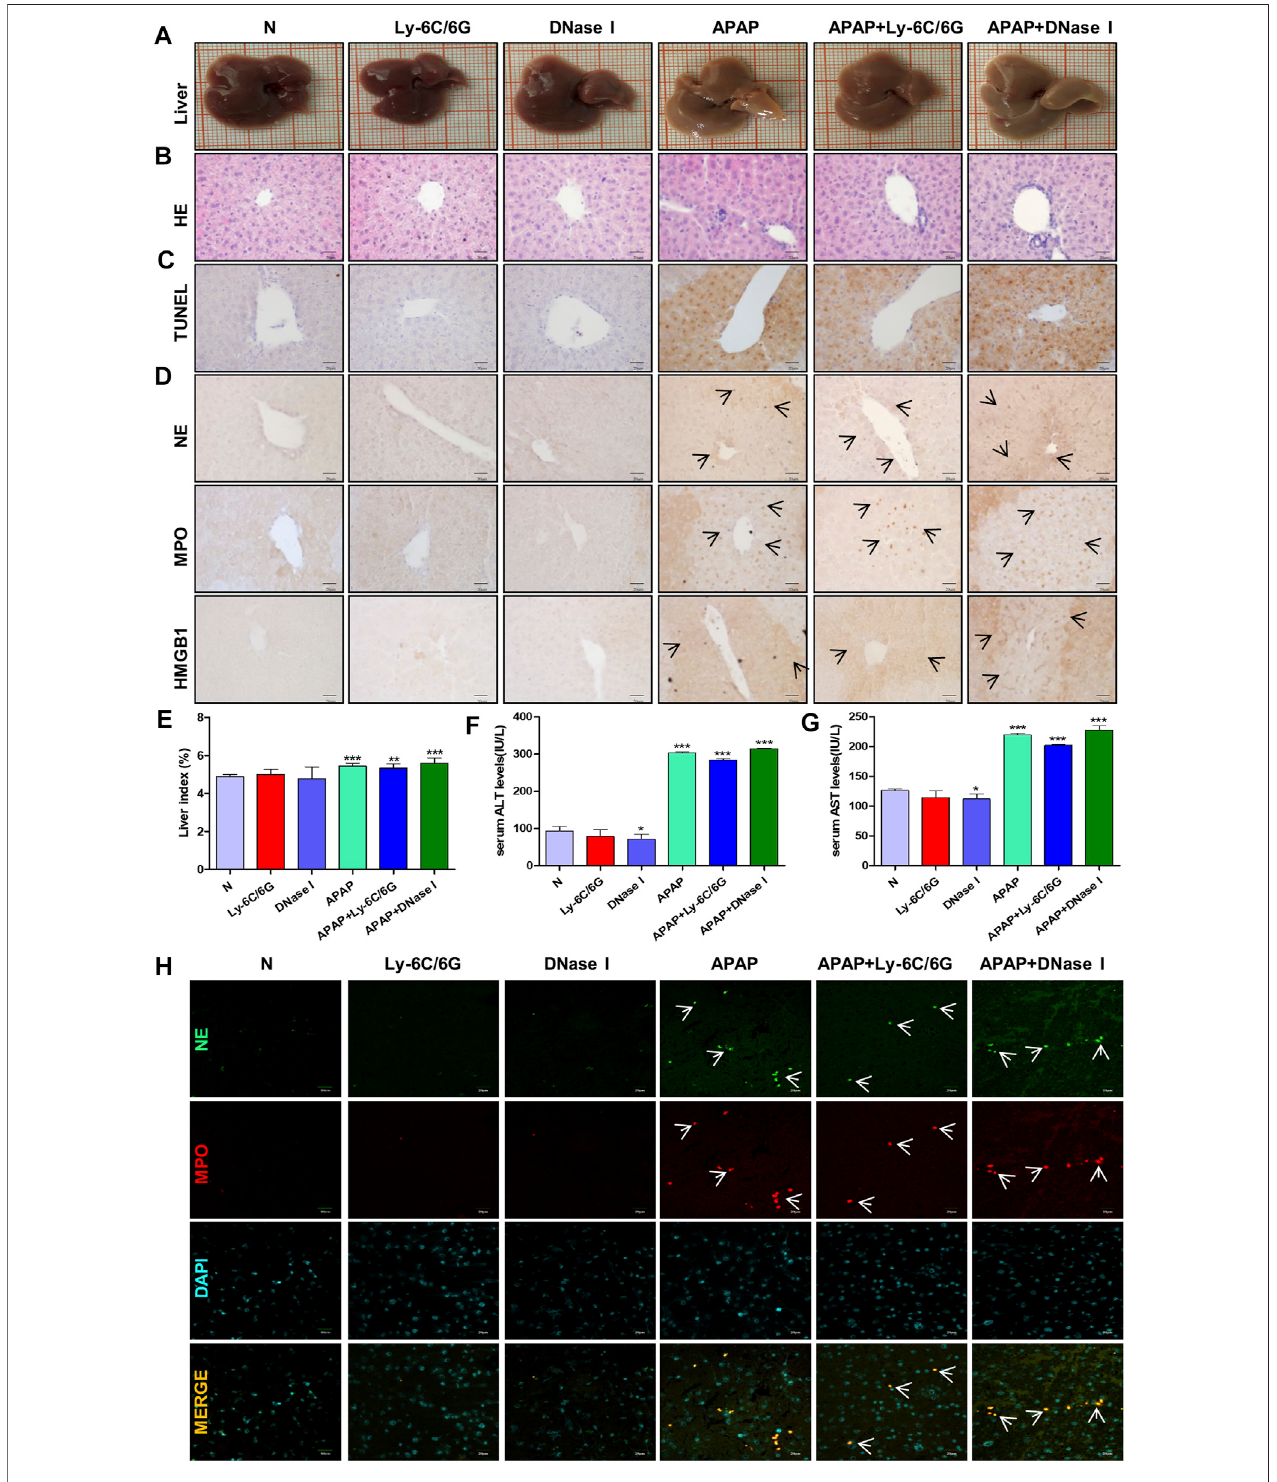
FIGURE7| Effects ofneutrophilsand NETs onliver injuryinduced byAPAP. C57BL/6 mice wererandomlydivided intosixgroups: normal group,Ly6C/6G group, DNase I group, APAP group, APAP + Ly6C/6G group and APAP + DNase I group. Ly6C/6G (200 μ g/mouse) was injected intraperitoneally 24 h before APAP (300 mg/kg) treatment. DNaseI(10 mg/kg) wasinjectedintraperitoneally1 hafter APAPtreatment. (A) Morphologyofmouselivertissue samples. (B,C) HEandTUNEL staining. (D) Immunohistochemical staining of NE, MPO and HMGB1. (E) Liver weight index. (F,G) The level of ALT and AST in serum. (H) Immuno fl uorescence stainingoffrozensectionsofNEandMPO.Greenandred fl uorescentlabelNEandMPO,orangeyellowlabelNEandMPOdualexpression.Allimagesweremagni fi edby 400 × . Speci fi c staining indicated by arrow. * p < 0.05, ** p < 0.01, *** p < 0.001, signi fi cantly different from the normal group. One-way ANOVA followed by Tukey ’ s test. The data are expressed as the mean ± SD of fi ve independent assays with at least three replicates.